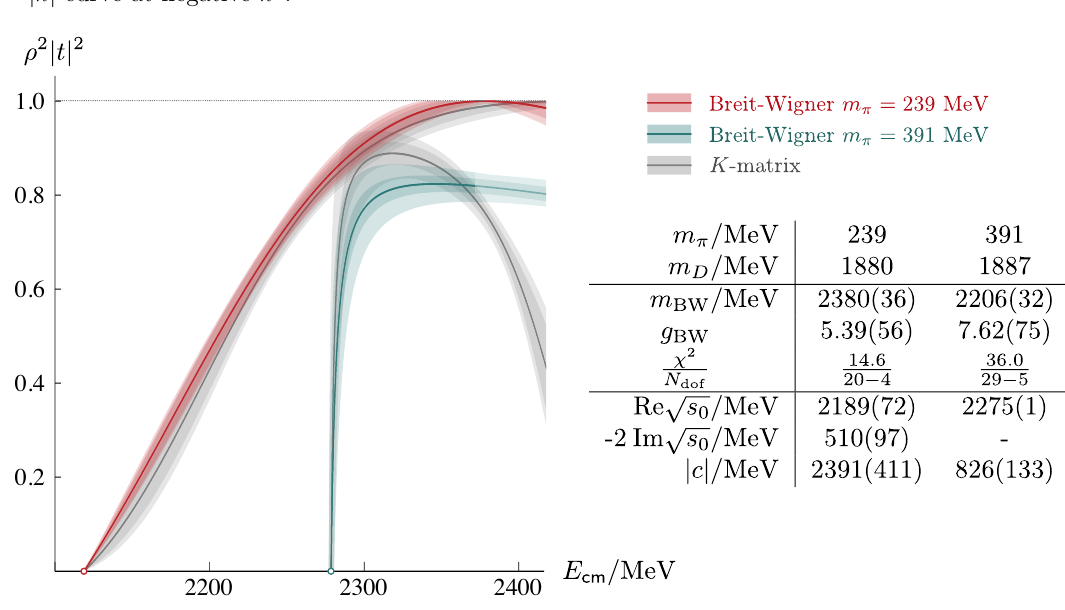
Figure 11. The S -wave scattering amplitudes at m π = 239 and 391 MeV plotted as k cot δ as a function of k 2 in scale-set units. Red shows the m π = 239 MeV amplitude and the m π = 391 MeV amplitude is shown in blue. The points shown come from using the finite volume energies individually in the Lüscher determinant condition. The bold square points are obtained from irreps at rest, the other points are obtained from moving frame irreps. In both cases the P -wave does not have a significant impact and was fixed to zero where it appears in moving frames. The bound state mass at m π = 391 MeV can be read off from the intersection of the blue curve with the dotted −| k | curve at negative k 2 .